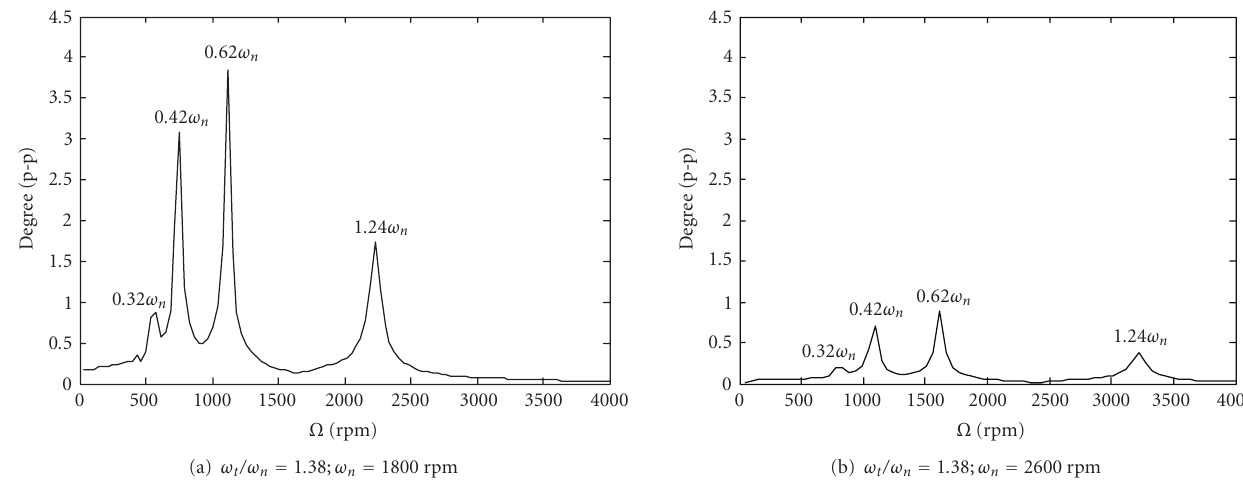
Figure 6: Overall peak-to-peak torsional vibration response, ϕ , general case, for cracked shafts with di ff erent lateral sti ff ness but constant torsional-to-lateral natural frequency ratio.